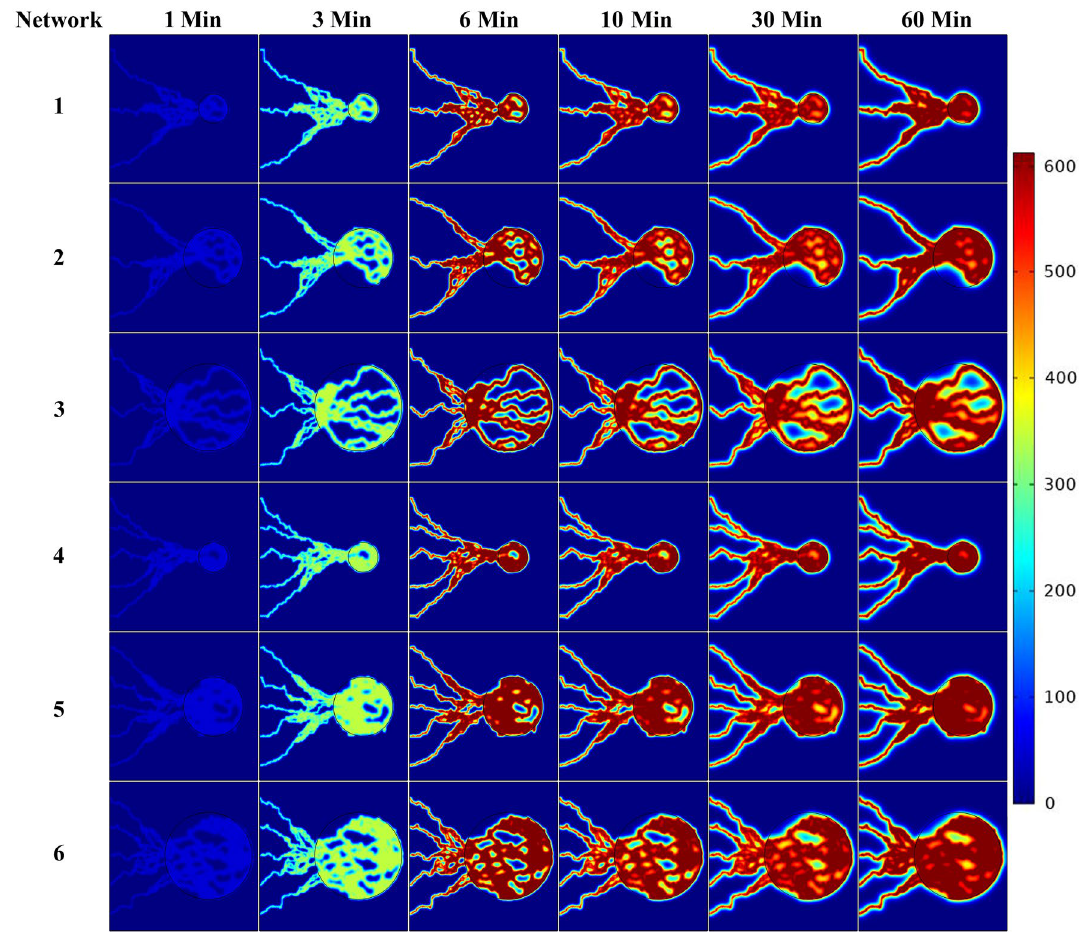
Figure 10. Spatiotemporal distribution of total FDG radiopharmaceutical concentration ( kBq ml ) at 1, 3, 6, 10, 30 and, 60 min in six